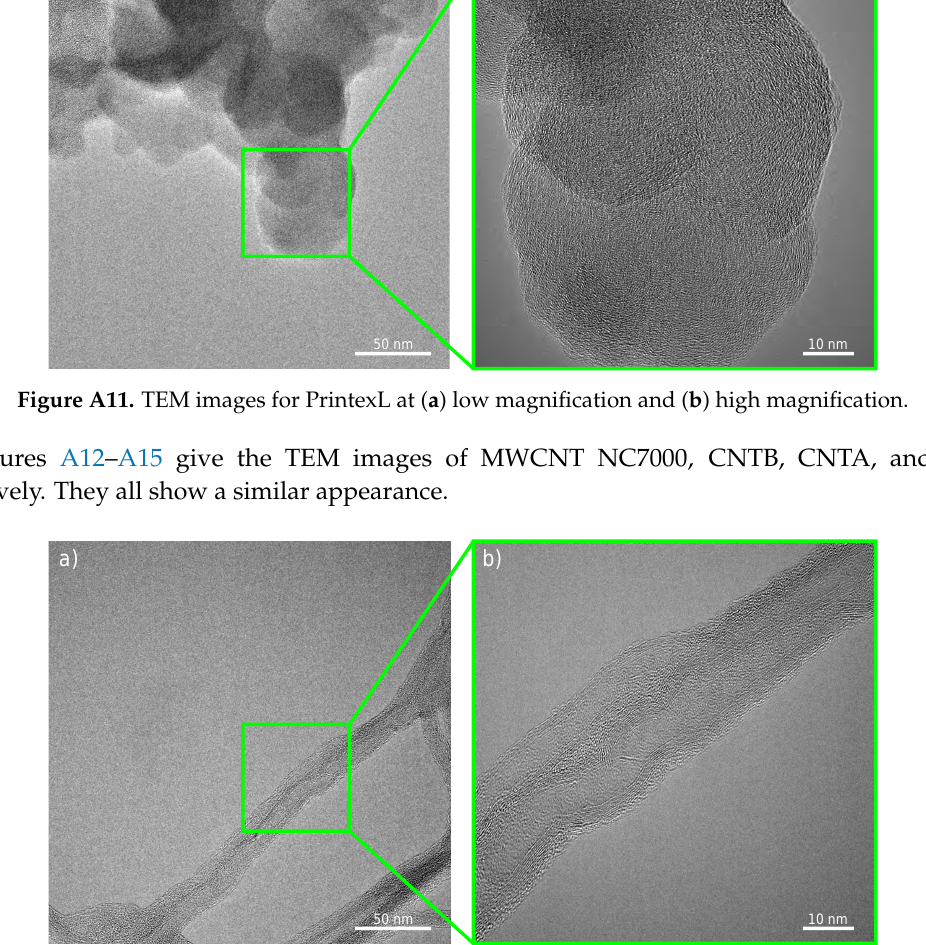
Figure A12. TEM images for NC7000 at ( a ) low magnification and ( b ) high